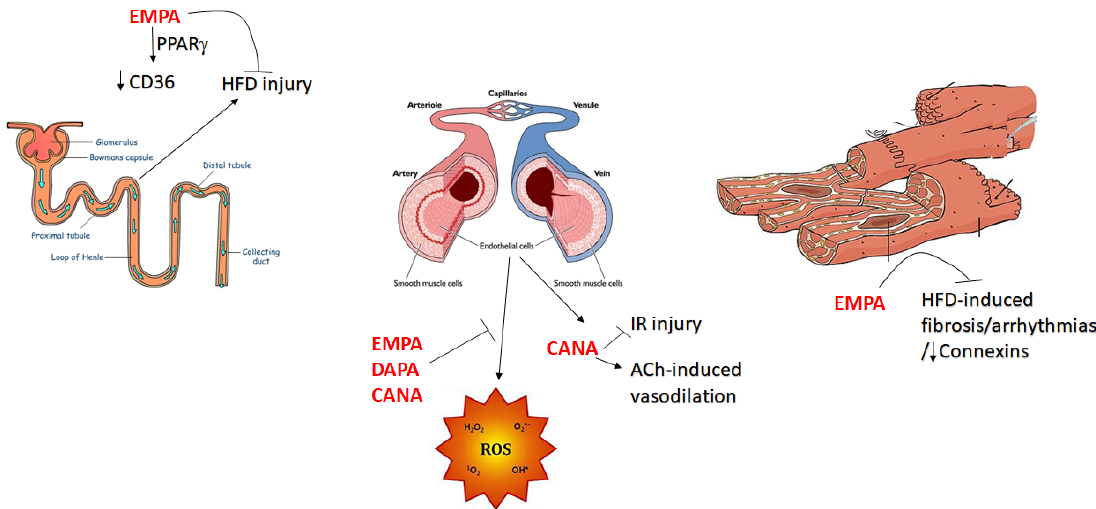
Figure 1. Protective effects of SGLT2 inhibitors in renal cells ( left ), vascular (coronary and aortic) en- dothelial cells ( middle ), and ventricular myocytes ( right ), as reported in this Special Issue [12,14–16]. See text for details. EMPA: Empagliflozin; DAPA: Dapagliflozin; CANA: Canagliflozin; ACh: